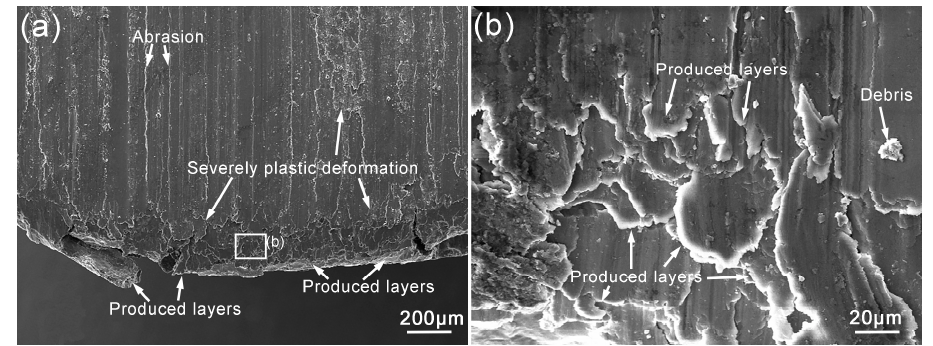
Figure 13. SEM images of protruded layers on the worn surface for the surfacing alloys with 1.5% Ce after sliding under 10 N and 1.25 m/s. ( a ) the protruded layers; ( b ) the corresponding enlarged view of (a).